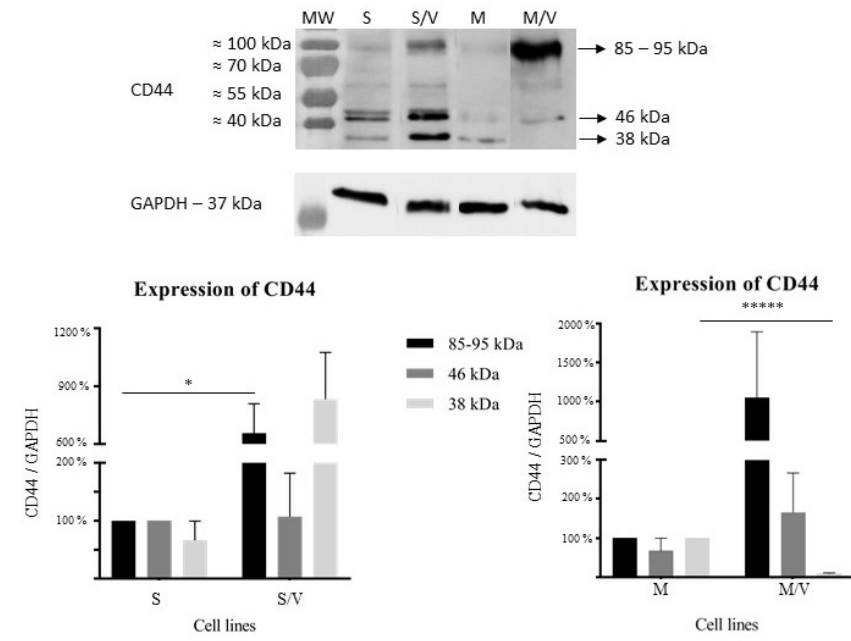
Figure 4. Protein expression of CD44. Upper panel—representative Western blot. Lower panel— densitometric analysis of all 3 protein bands (38, 46 and ≈ 85–95 kDa) in SKM-1 and SKM-1/VCR ( left ) and MOLM-13 and MOLM-13/VCR ( right ). Data represent the mean ± SEM of 3 independent experiments. Statistical significance as follows: * p ≤ 0.05; ***** p ≤ 0.000001. MW—marker of molecular weight; S—SKM-1; S/V—SKM-1/VCR; M—MOLM-13; M/V—MOLM-13/VCR.